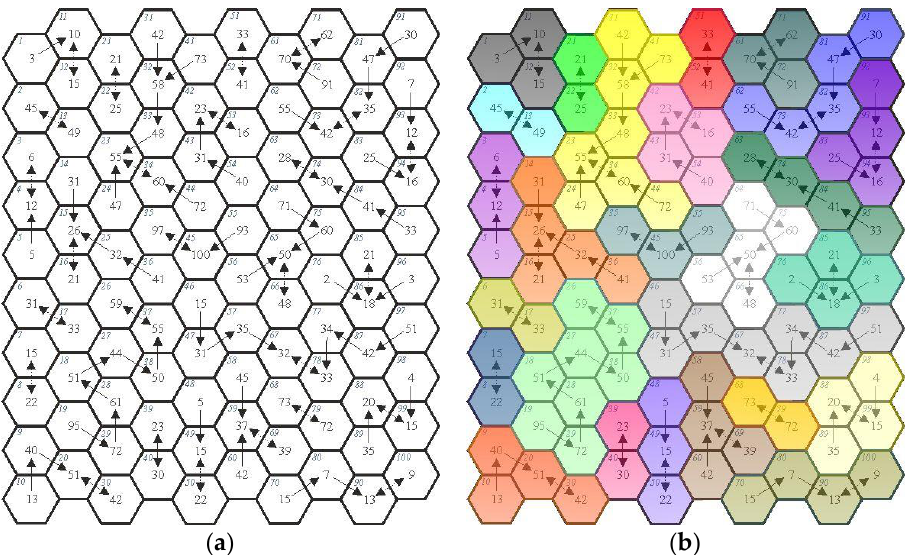
Figure 1. The stages of network emergence according to the minimum value difference path: ( a ) the stage of revealing the minimum difference relationship, and ( b ) the first stage of value aggregation and the emergence of new regions. Source: Own analysis.